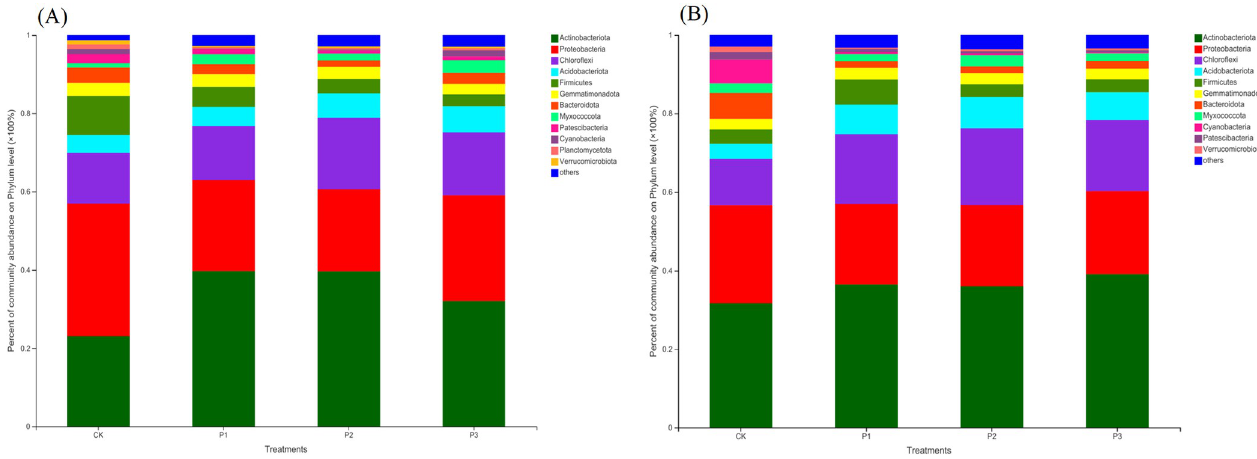
Fig 2. Bacterial community composition based on Phylum level. A is 0–30 soil layer, B is 30–60 cm soil layer.